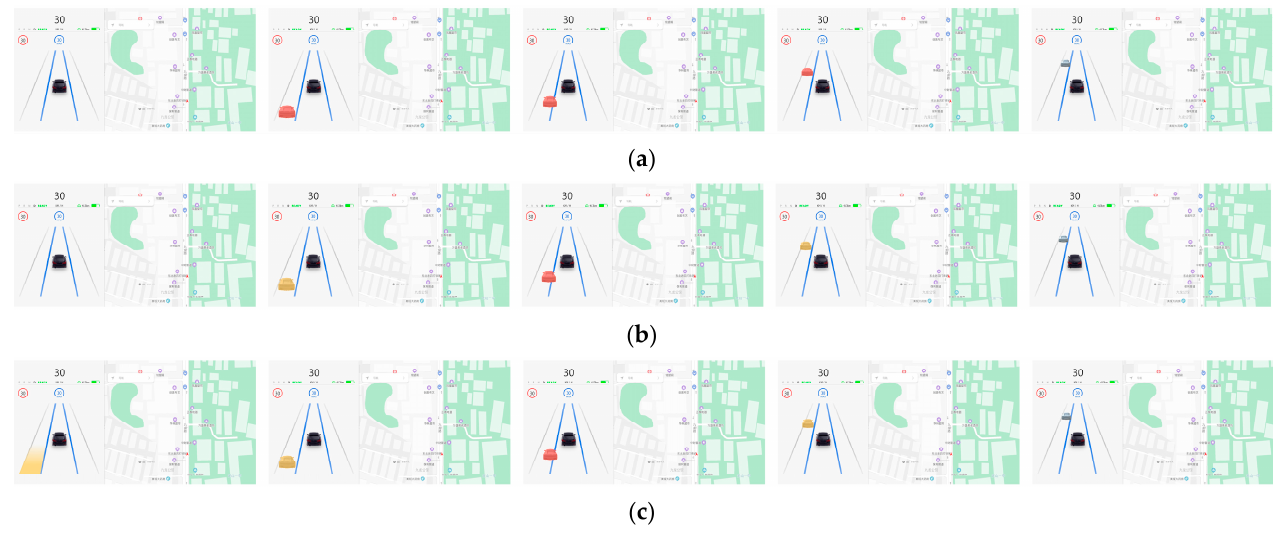
Figure 5. Experimental prototype of the three designs. ( a ) Design1; ( b ) Design2; ( c ) Design3.